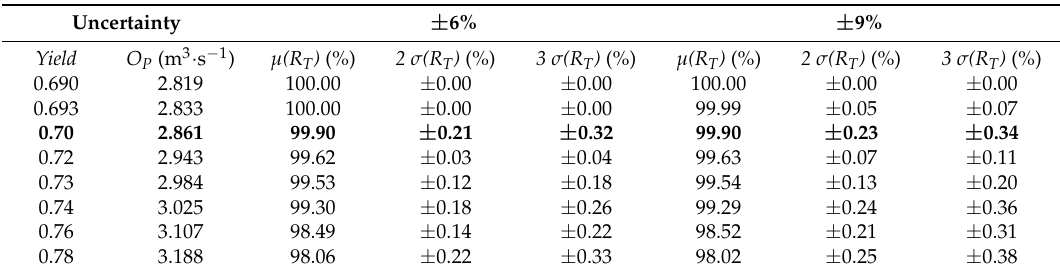
Table 2. Calculation of temporal reliability of water outflow from the reservoir considering the input